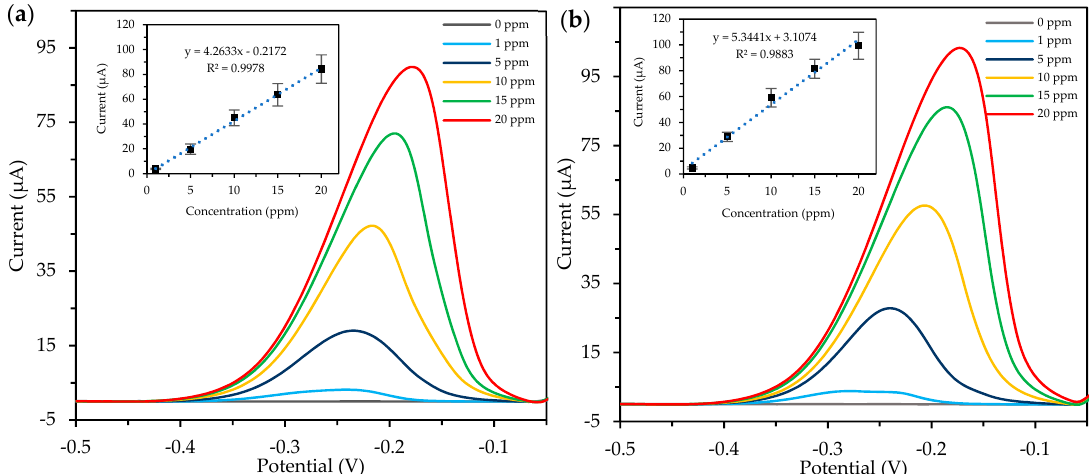
Figure 6. Detection of Cu 2+ ions in free solution by the differential pulse voltammetry analysis in 0.1M KCl/HCl buffer. ( a ) SPCE modified with chitosan and green synthesised AuNPs and ( b ) SPCE modified with chitosan and citrate-capped AuNPs.